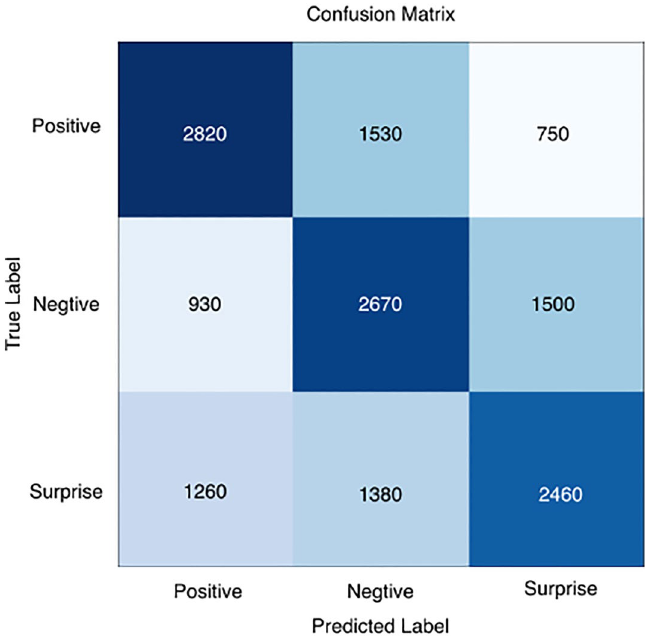
Figure 9. Confusion matrix in the ShuffleNetV2 with CBAM + Softmax case.